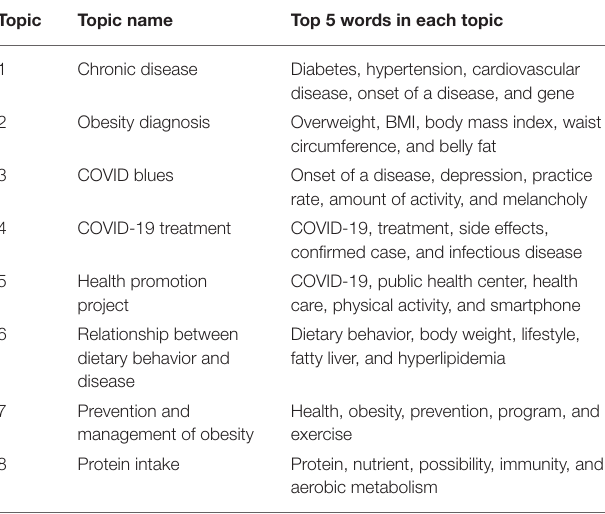
TABLE 7 | Topic modeling after the COVID-19